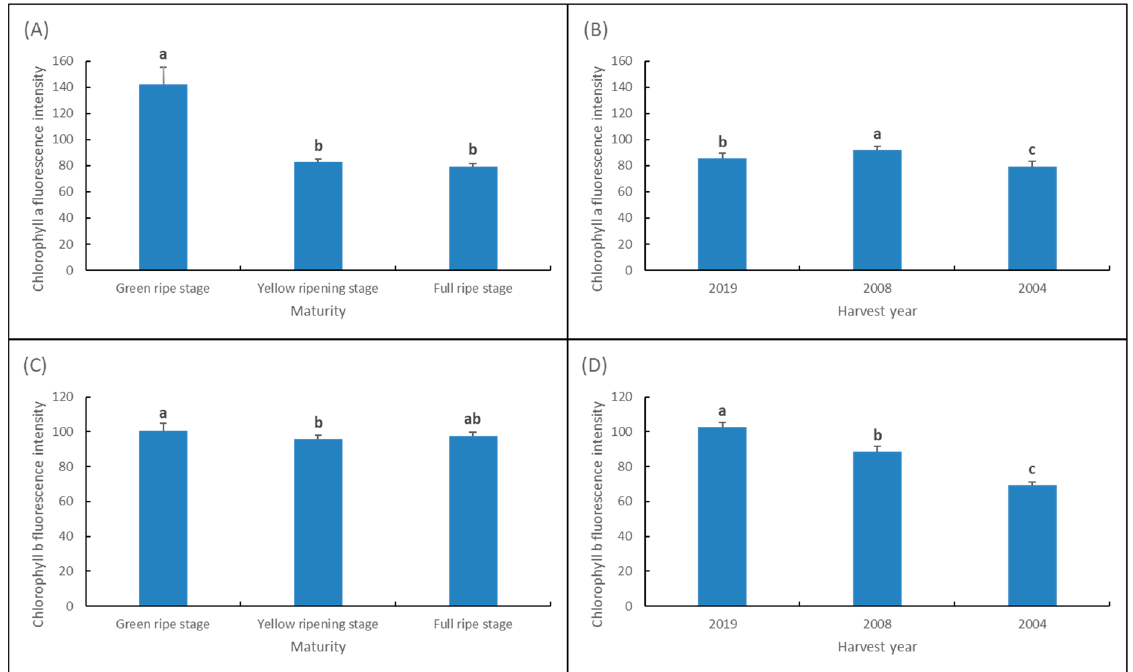
Figure 3. Chlorophyll A and chlorophyll B fluorescence intensity of seeds at different maturity lev- els and harvest years. ( A ) Chlorophyll A fluorescence intensity of seeds at different maturity levels. ( B ) Chlorophyll A fluorescence intensity of seeds at different harvest years. ( C ) Chlorophyll B fluo- rescence intensity of seeds at different maturity levels. ( D ) Chlorophyll B fluorescence intensity of seeds at different harvest years. Note: Different lowercase letters indicate significant differences ( p < 0.05).